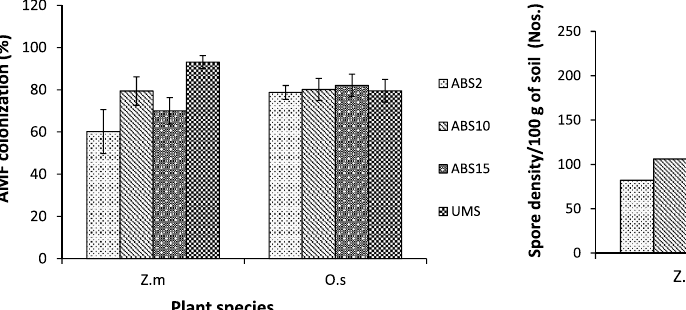
Fig. 1. AMF colonization (%) in Zea mays L. (Z.m) and Oryza sativa L. (O.s) used as trap plants set up with study sites derived inocula.